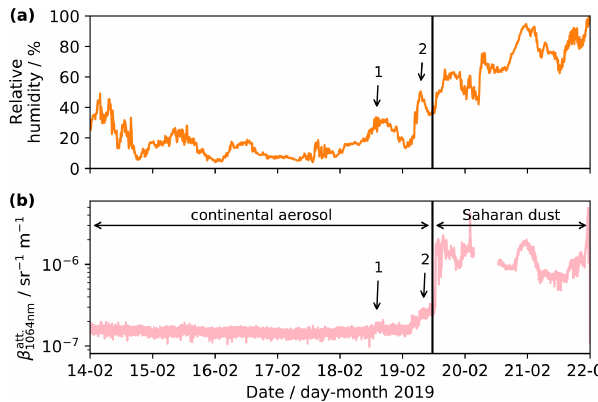
Figure A1. (a) Relative humidity observed during the compari- son period (14–22 February 2019) on 19 February 2019 at WFJ (mountaintop site). The two peaks in relative humidity during the transition time are indicated with 1 and 2. (b) Observed lidar attenuated backscatter coefficient β att . at the height of WFJ 1064nm (2687ma . s . l . ). The two characteristic time periods for continental background aerosol and Saharan dust are indicated. Two perturba- tions in β att . during the transition time are indicated with 1 and 1064nm 2,